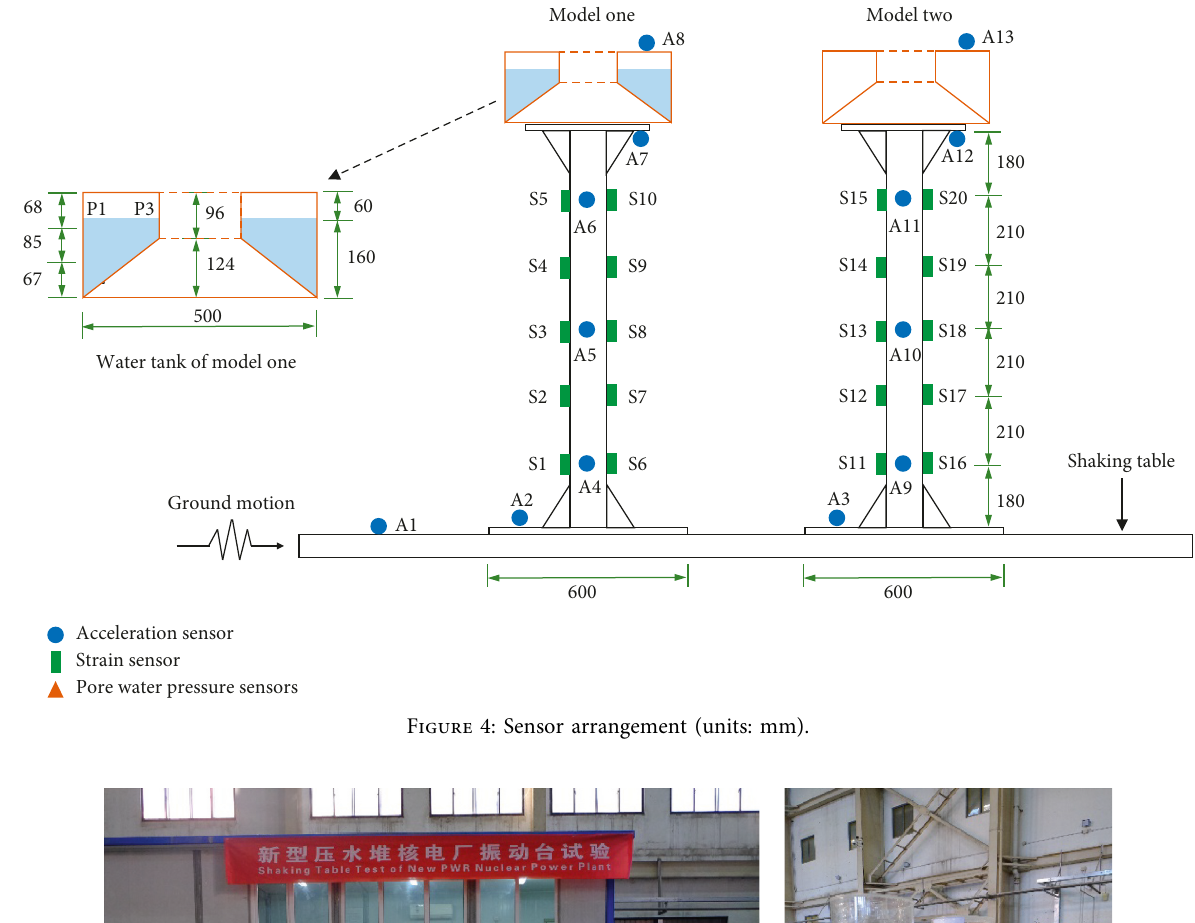
Figure 4: Sensor arrangement (units: mm).